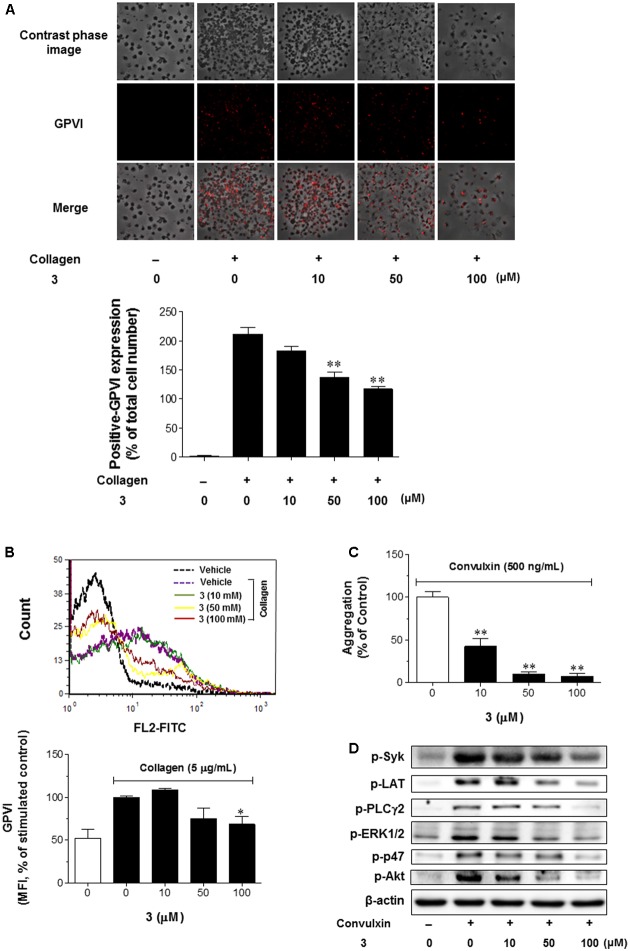
3 suppresses the activation of platelet receptor GPVI to inhibit platelet aggregation. (A) Washed rabbit platelets in CaCl2 (1 mM) were incubated for 3 min with 3 (10, 50, and 100 μM) or DMSO and then stimulated with collagen (5 μg/ml) for 5 min. After rinsing the cells with PBS, platelets were added on the collagen-coated 24-well plates. After 1 h incubation at room temperature, unbound platelets were removed, and adherent platelets were fixed by 3% paraformaldehyde and stained for anti-GPVI-FITC antibody. After GPVI staining, platelets were visualized by confocal fluorescent microscopy. The data shown in bar graphs expressed as the means ± SEM represent the GPVI-positive cell numbers after normalization with total cell numbers, and are an average of three similar and independent experiments. The images are representative microscopic pictures from three similar and independent experiments. ∗∗p < 0.01 vs. control (collagen treatment, but no 3). (B) At the separate experiment set with the same condition, GPVI-FITC positive cells were counted using flow cytometer (upper panel). Bar graph represents the geometric mean percentage of GPVI-positive cells in the non-treated control and collagen-stimulated platelets (lower panel), which are an average of three similar and independent experiments. ∗p < 0.05 vs. control (collagen treatment, but no 3). Platelet aggregation (C) or intracellular signaling pathway (D) was induced by the addition of a GPVI specific agonist convulxin (500 ng/mL). Washed rabbit platelets in CaCl2 (1 mM) were incubated for 3 min with 3 (10–100 μM) or DMSO followed by convulxin stimulation for 5 min. Then, platelet aggregation was measured and the results expressed as the means ± SEM are an average of three similar and independent experiments, ∗∗p < 0.01 vs. control (convulxin treatment, but no 3) (C). At the separate experiment set with the same condition, total proteins were extracted and western blotting against indicated antibodies was performed to investigate the effect of 3 on GPVI-mediated intracellular signaling pathway (D). The gel images are of representative blots from three similar and independent experiments.